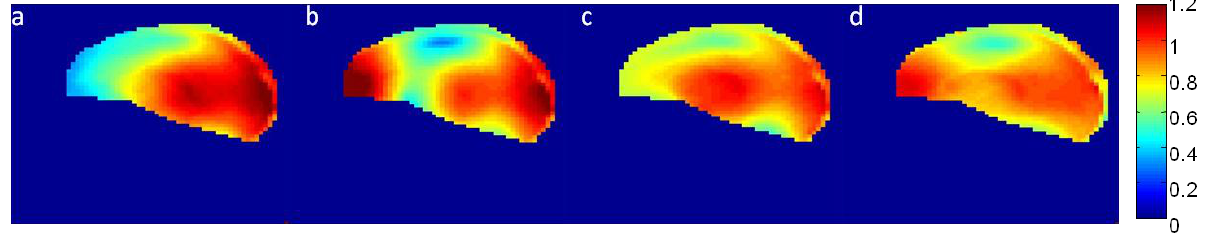
Figure 3. Representative measured sagittal B 1+ maps shimmed with static RF shim, B 1+ maps with four different Tx channel configurations: ( a ) 1-channel Tx; ( b ) 2-channel Tx; ( c ) 4-channel Tx and ( d ) 8-channel